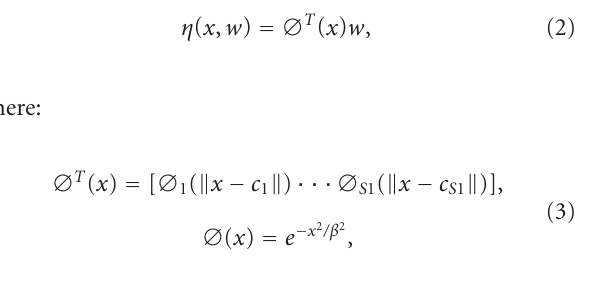
Table 1: Cruise control system variables and values used for simulation.